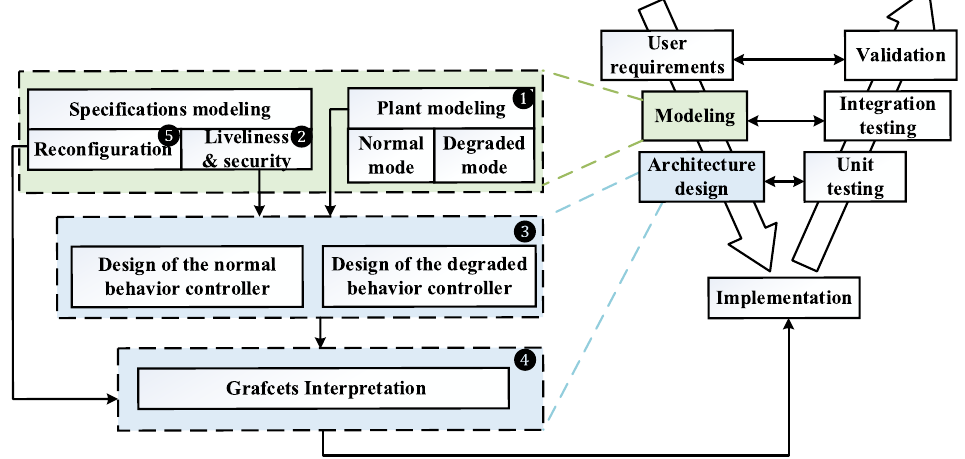
Figure 4. Formal architecture for reconfigurable and fault-tolerant control synthesis.